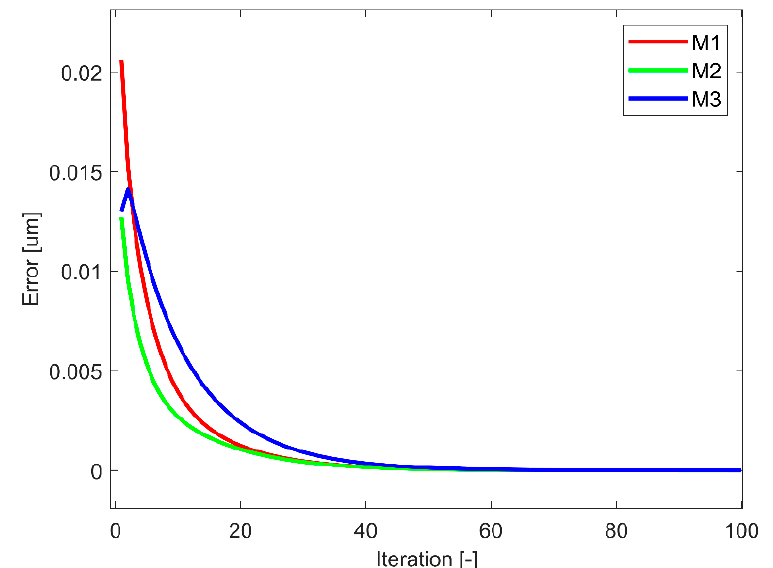
Figure 8. Difference between the nominal and compensated point positions depending on the num- ber of iterations. of